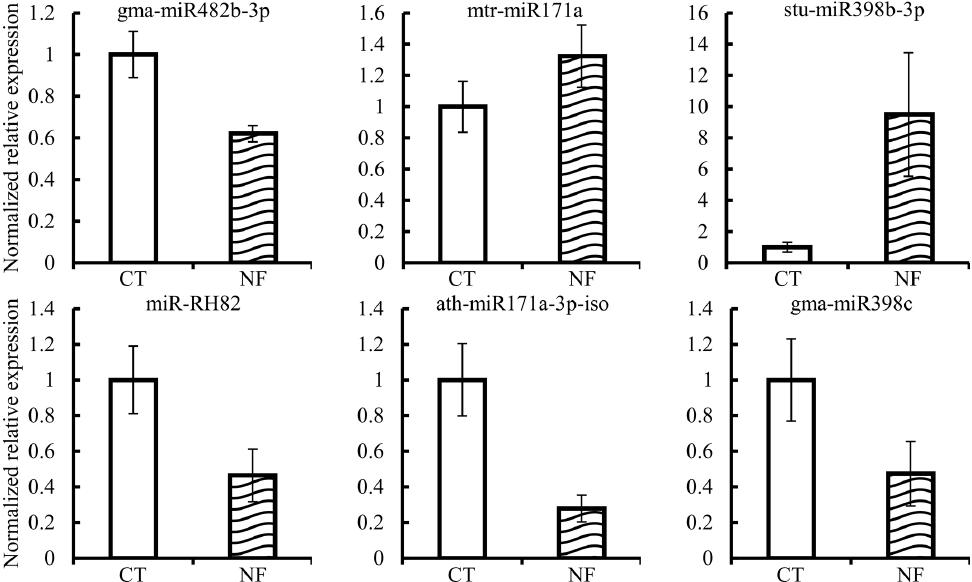
Figure 2. Mature miRNA differentially expressed in NF-induced RH single-cells, based on high throughput sequencing data. White and striped histograms represent the mean of expression values from control (CT, mock-induced) and NF-induced (NF) samples, respectively. Expression values are normalized to the value of the control condition that was set to 1. Error bars represent the standard error of the mean of the three relative expressions from three biological replicates of each treatment.